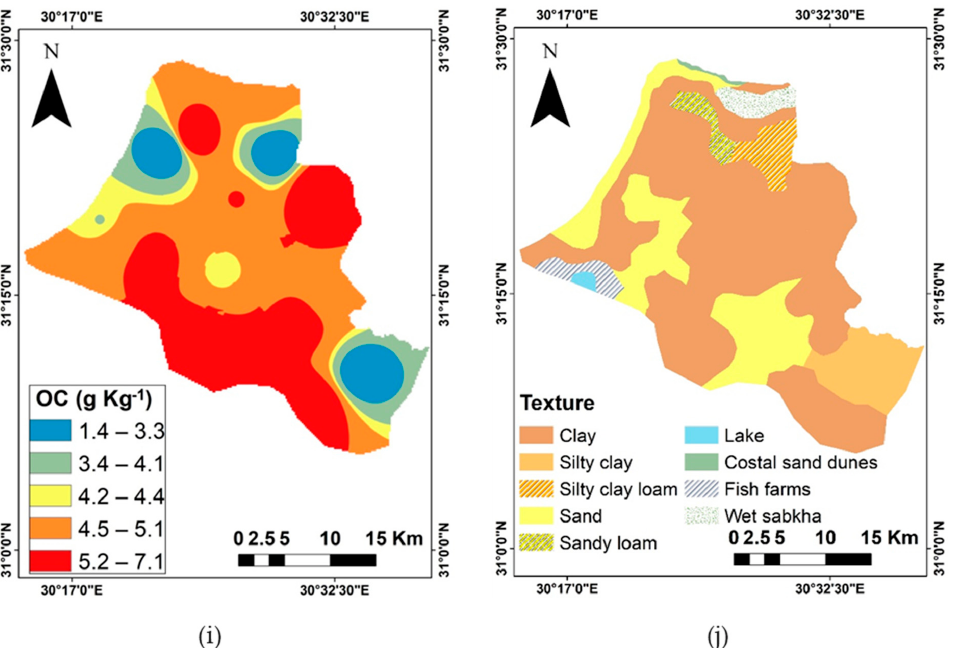
Figure 6. Mean weight spatial distribution of the studied soil properties and total concentrations of heavy metals ( a ) As (mg Kg -1 ), ( b ) Co (mg Kg -1 ), ( c ) Cu (mg Kg -1 ), ( d ) Ni (mg Kg -1 ), ( e ) V (mg Kg -1 ),